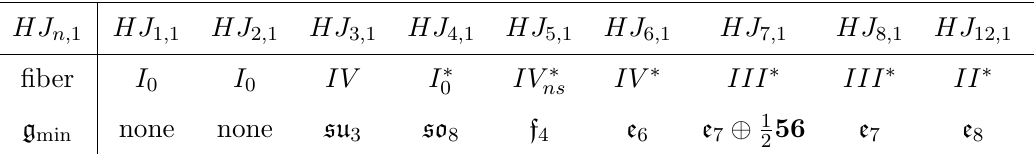
56 representation of e 7 . 2